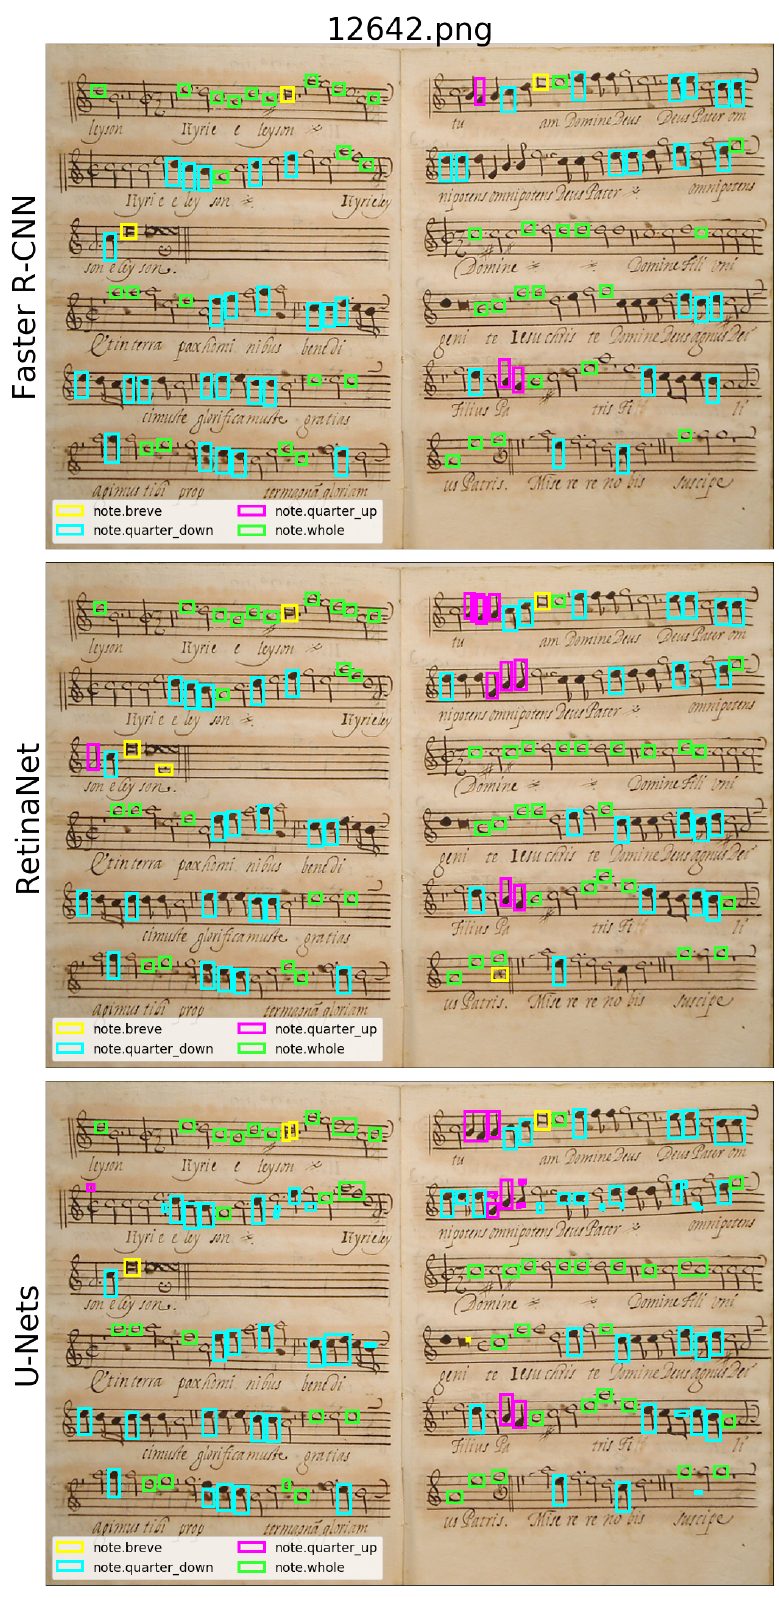
Figure 7. Detection sample on some selected classes from the Capitan dataset. ( top – bottom ): Faster R-CNN, RetinaNet, and U-Nets detection